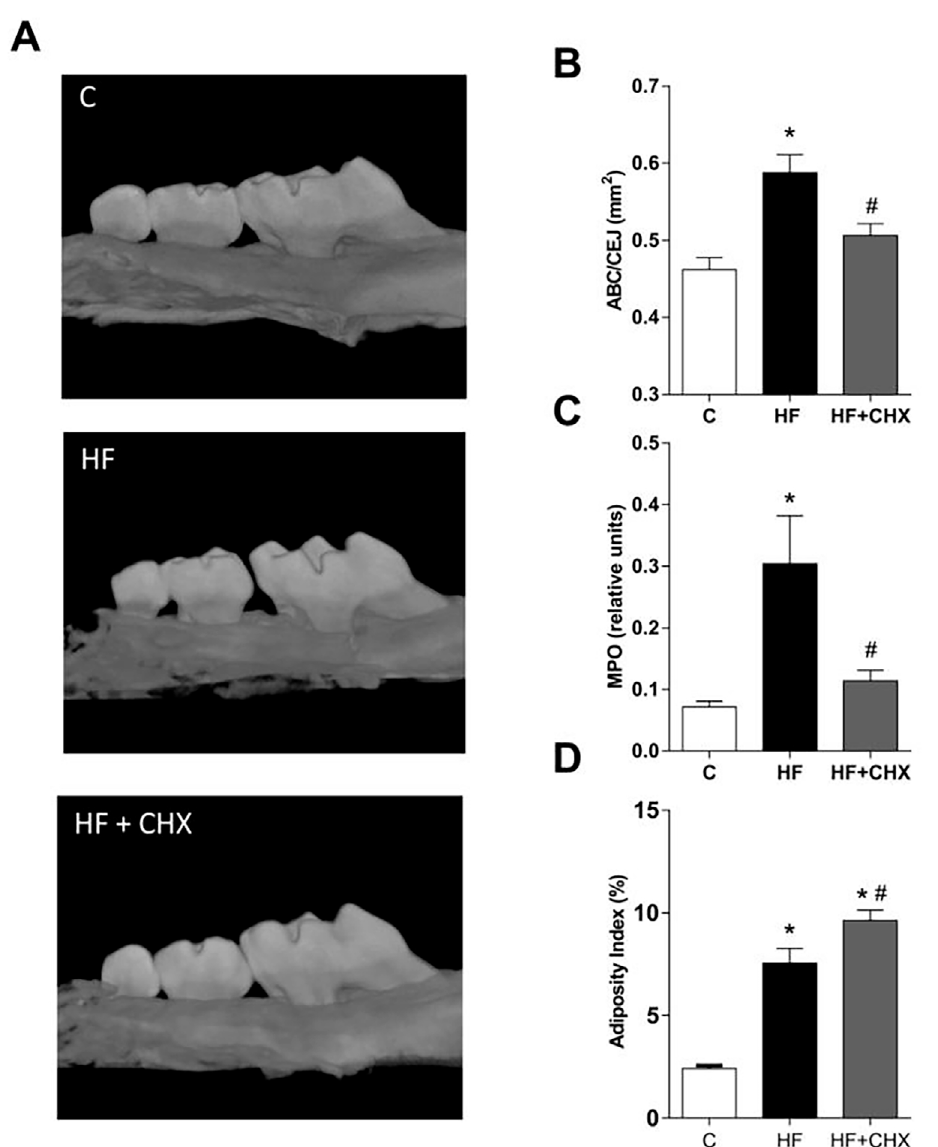
Figure 4- Topical application of CHX impairs HF diet-induced alveolar bone loss. (A) Representative images of hemimaxillae of mice from different experimental groups. (B) Alveolar bone loss evaluation after 12 weeks of diet and 4 weeks after CHX treatment. (C) Neutrophil influx. *p<0.05 when compared to the control group; N=5, #p<0.05 when compared to the HF group. (D) Adiposity measurements after 12 weeks of diet and 4 weeks after CHX treatment.* *p<0.05 when compared to the control group; N=5, #p<0.05 when compared to the HF group. One-way ANOVA followed by Newman-Keuls. The values (mean ± S.E.M) of all experiments were obtained from two independent experiments with a total of 30